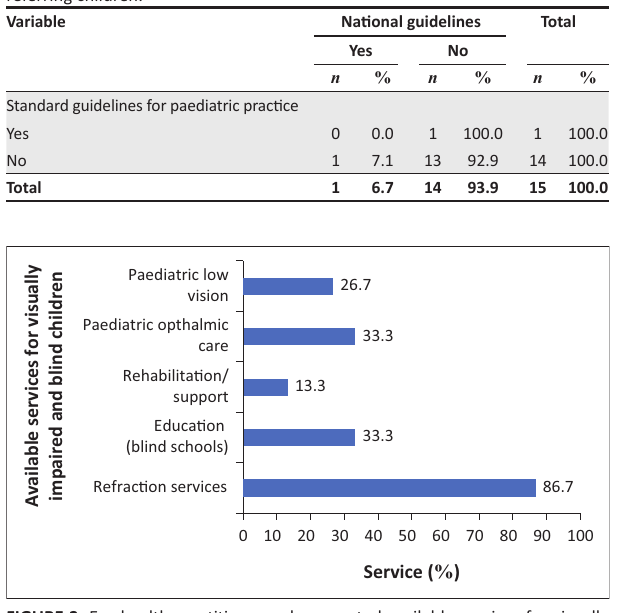
FIGURE 2: Eye health practitioners who reported available services for visually impaired and blind